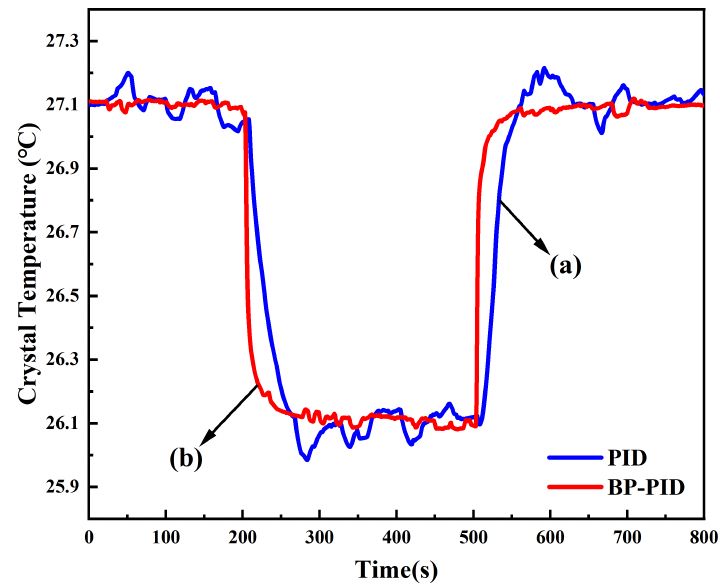
Figure 6. Comparison between traditional PID control and BP neural network PID control when changing the same temperature. The blue line (a) is traditional PID control, and the red line (b) is BP neural network PID control. The temperature decreased by 1 °C in 200 ∼ 500 s and increased by 1 °C in 500 ∼ 800 s.